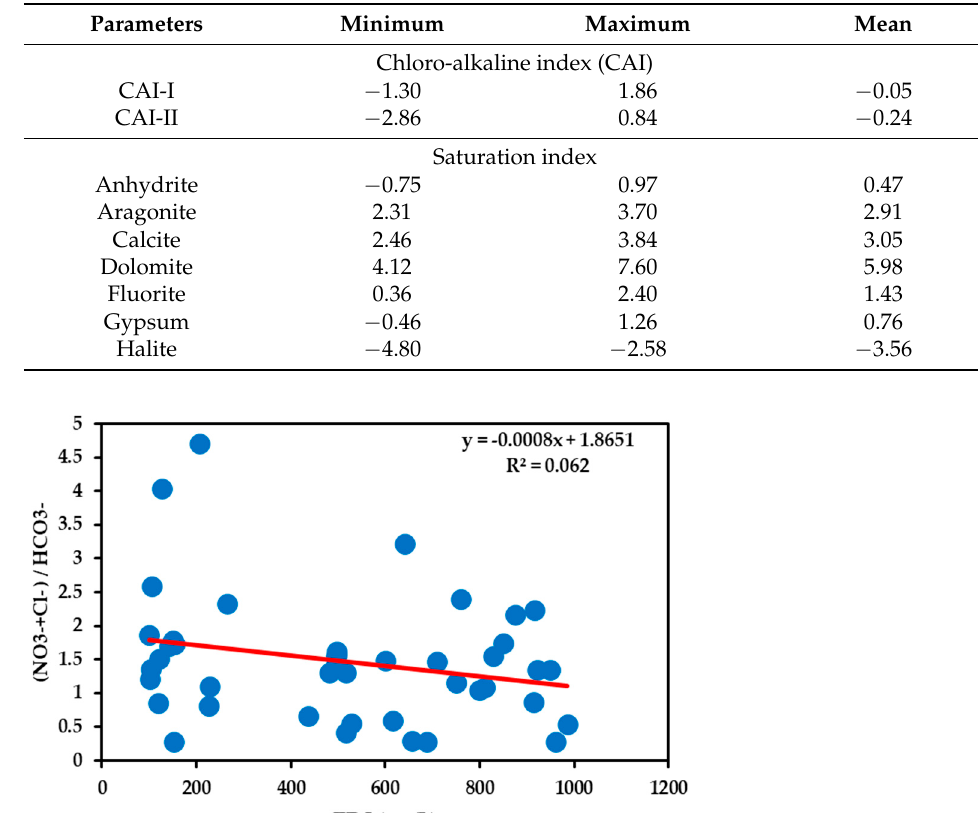
Table 6. Description statistical analysis of chloro-alkaline and saturation indices. Figure 13. Ion exchange diagram of groundwater samples in study region.